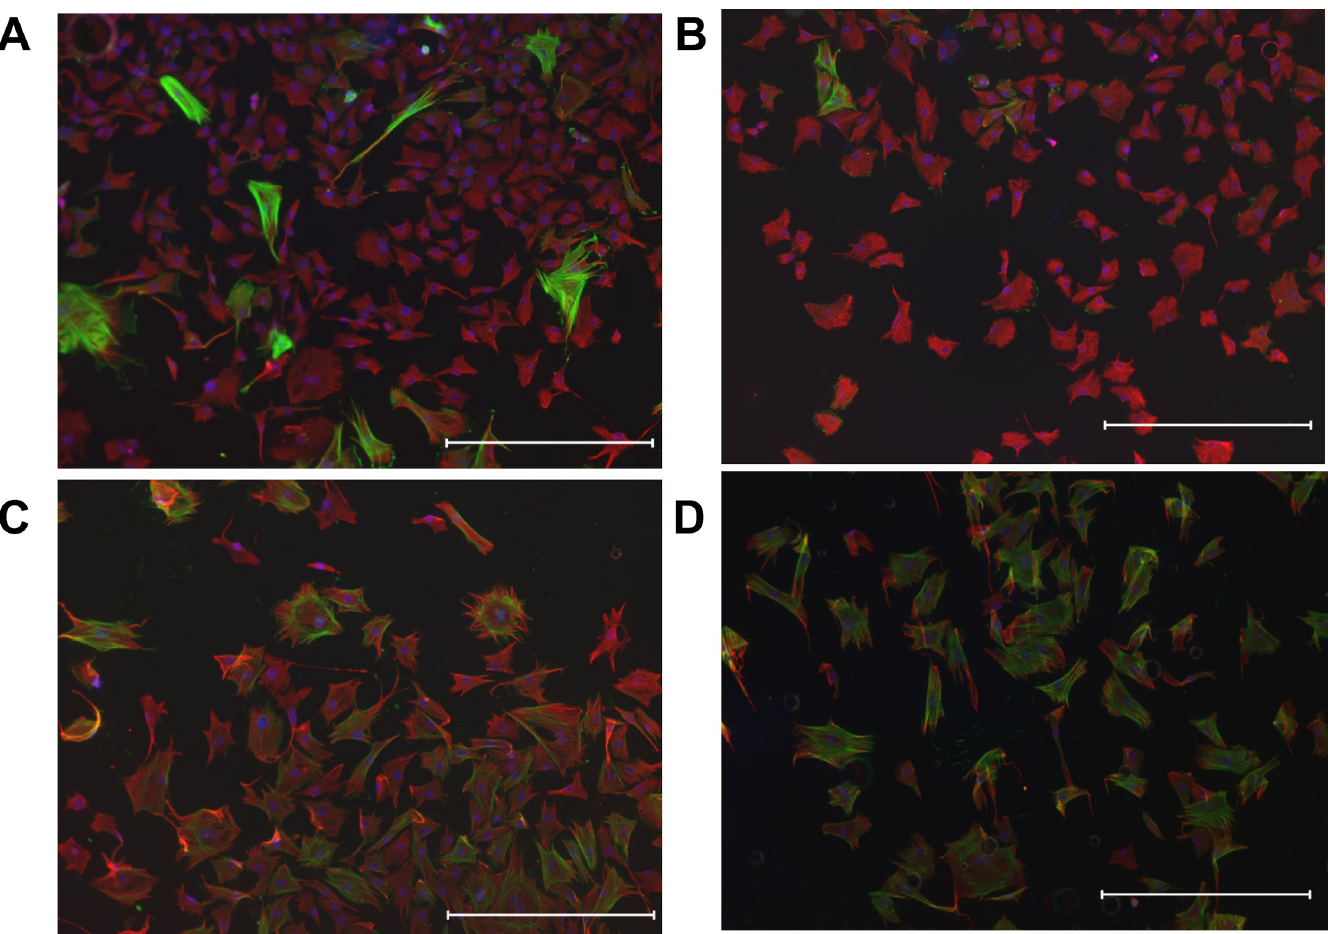
Fig 5. Immunohistological staining of fibroblasts. (A) Control. (B) After treatment with 25 ng/mL FGF23. (C) After treatment with 10 ng/mL TGF- β 1. (D) After treatment with both 25 ng/mL FGF23 and 10 ng/mL TGF- β 1. Red: α -SMA; Green: vimentine; Blue: nuclear staining with 4, 6-diamidino-2-phenylindole (DAPI). Scale bar indicates 500 μ